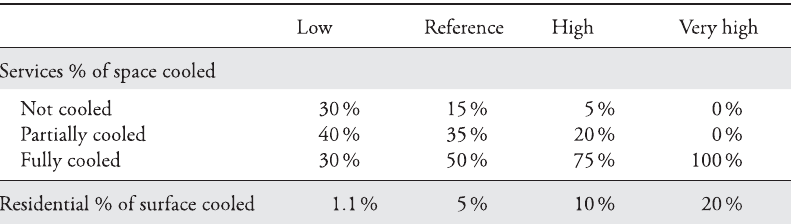
Table 7: Assumptions on Cooled Surfaces in